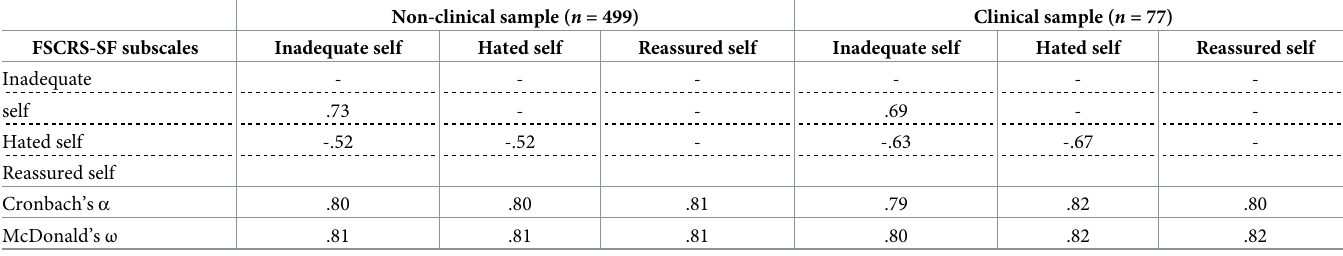
Table 3. Pearson intercorrelations and internal consistency of the FSCRS-SF subscales in clinical and non-clinical samples.